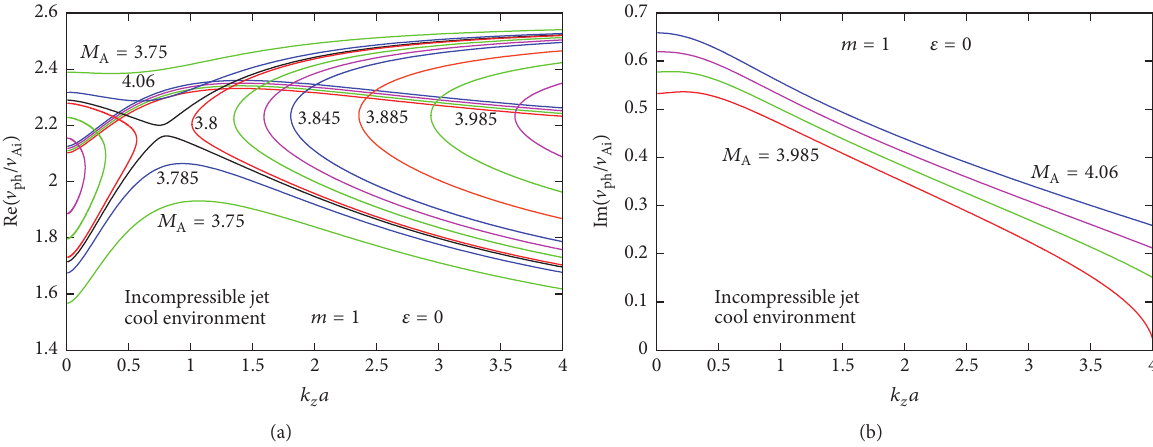
Figure 3: (a) Dispersion curves of stable and unstable kink ( 𝑚 = 1 ) MHD mode propagating in a moving untwisted magnetic flux tube of incompressible plasma surrounded by cool medium at the same input parameters as in Figure 2. The dispersion curves of unstable modes located above the middle of the plot have been calculated for 𝑀 A = 3.985 , 4.01, 4.035, and 4.06. Alfv´en Mach numbers associated with the nonlabeled black, green, and purple curves are equal to 3.796, 3.815, and 3.83, respectively, while those of far right green and purple semiclosed curves have magnitudes of 3.925 and 3.965. (b) Similar plots as in Figure